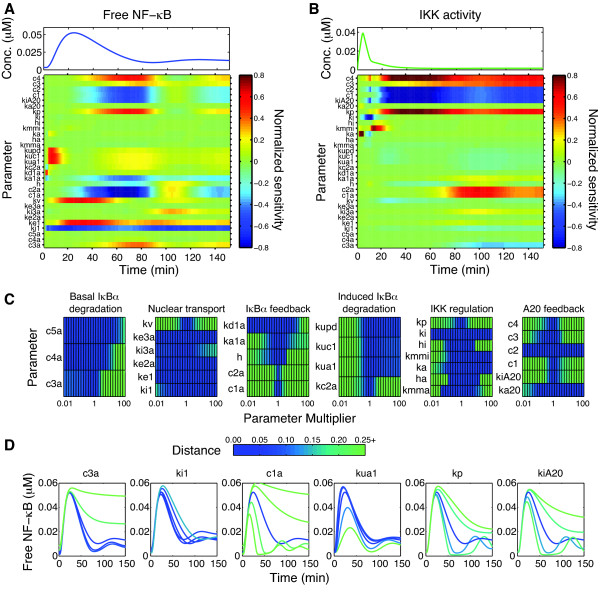
Model analysis of transient IKK and NF-κB activation in microglia. Sensitivity analysis of the model shows the dynamic NF-κB response (A) and IKK response (B) are regulated differently by different groups of parameters depending on the time interval of interest. See Additional file 1: Tables S2-S3 for complete descriptions of the parameters. (C) Parameter scans were used to find the Euclidean distance between the nominal and perturbed NF-κB responses as the parameters varied over four orders of magnitude. Dark colors indicate little change, while lighter colors indicate large changes. (D) Simulated trajectories from the parameter scans for selected parameters from each group show distinctions in how the system is affected by up to +/- 10-fold changes from the nominal values. See also Additional file 1: Figures S7 and S8.